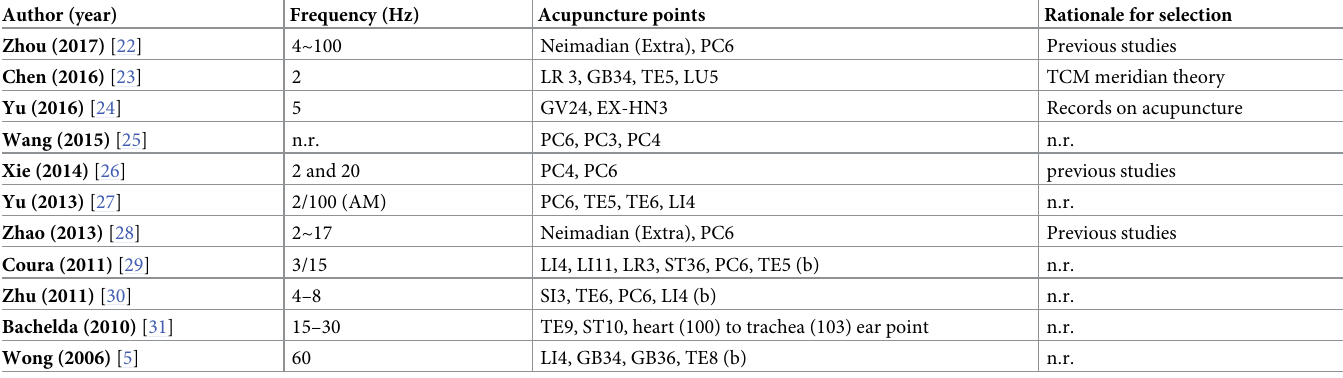
Table 2. Summary of acupuncture points used in the intervention